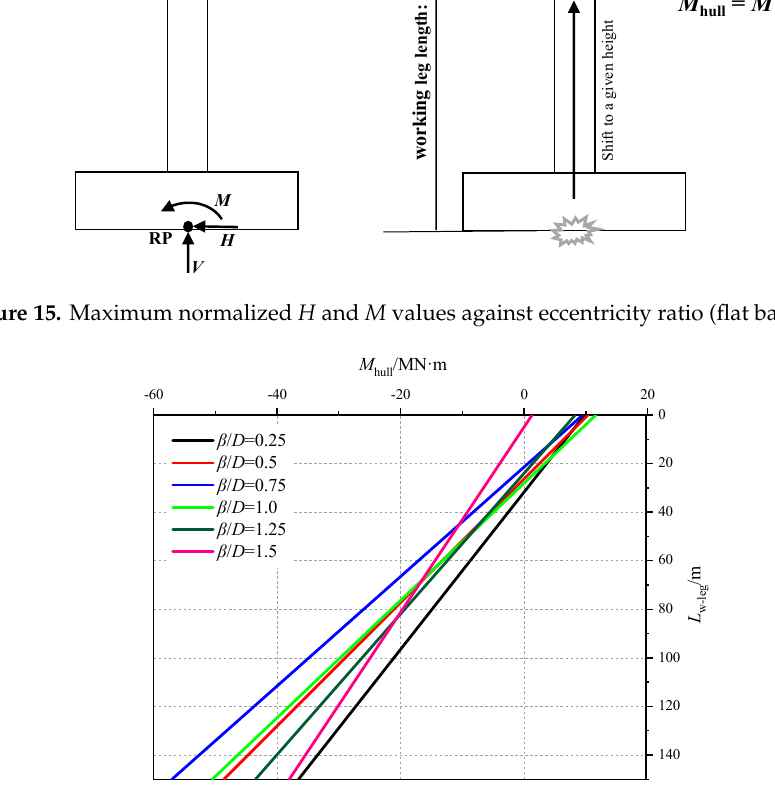
Figure 16. The bending moment on the leg − hull connection section (flat base footing, TB).